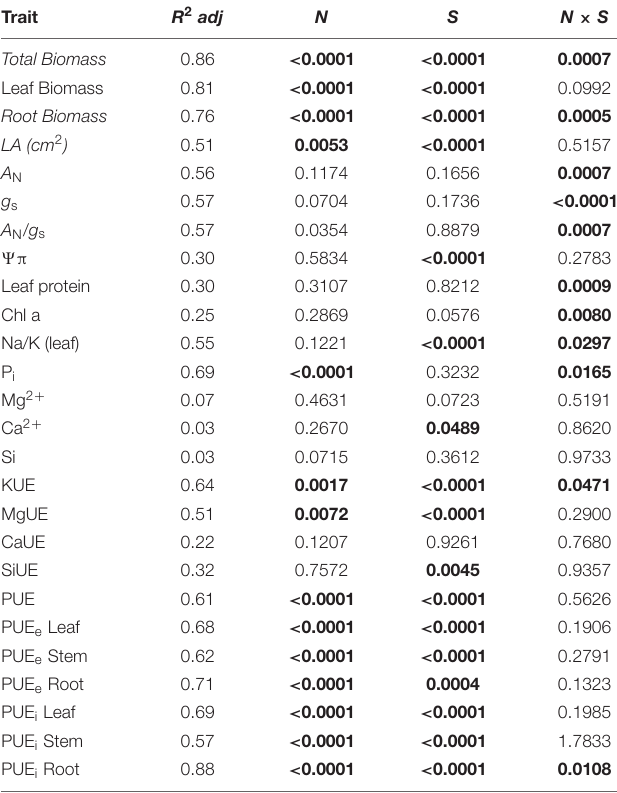
TABLE 1A | Summary of two-way analysis of variance (ANOVA) and R saquere adjusted of the total model ( R 2 adj) for the effects of nutrient treatment (N) and salt treatment (S), with their interaction factor (N × S) on biomass, physiological and nutrition- related traits in Arundo donax plants.